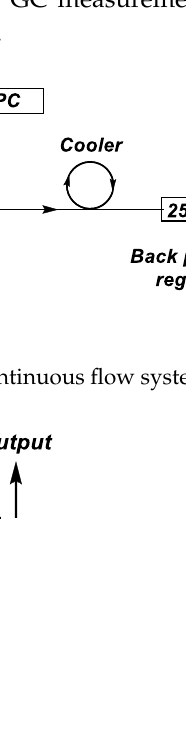
Figure 2. Sketch of the continuous flow cell.